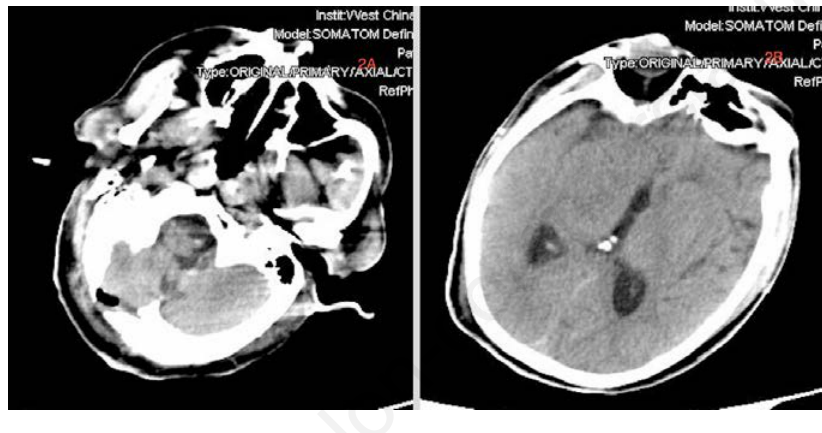
Figure 2. Postoperative CT-Scan showing total resection of the lesions with very mild edema.